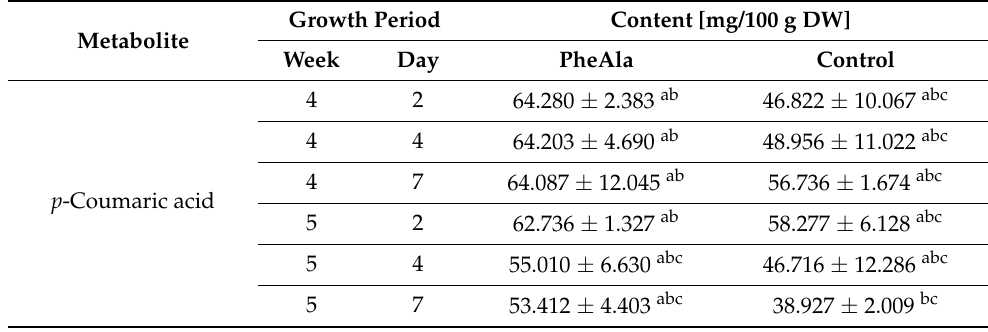
Table 2. Average content of phenolic compounds (phenolic acids, catechin) [mg/100 g DW] in hydrolysates obtained from the biomass of R. graveolens agitated cultures, depending on the duration of the growth cycle (4 and 5 weeks) and day after addition of phenylalanine (2, 3, and 7 days). Means of three measurements ± SD. Different letters indicate significant differences ( p <